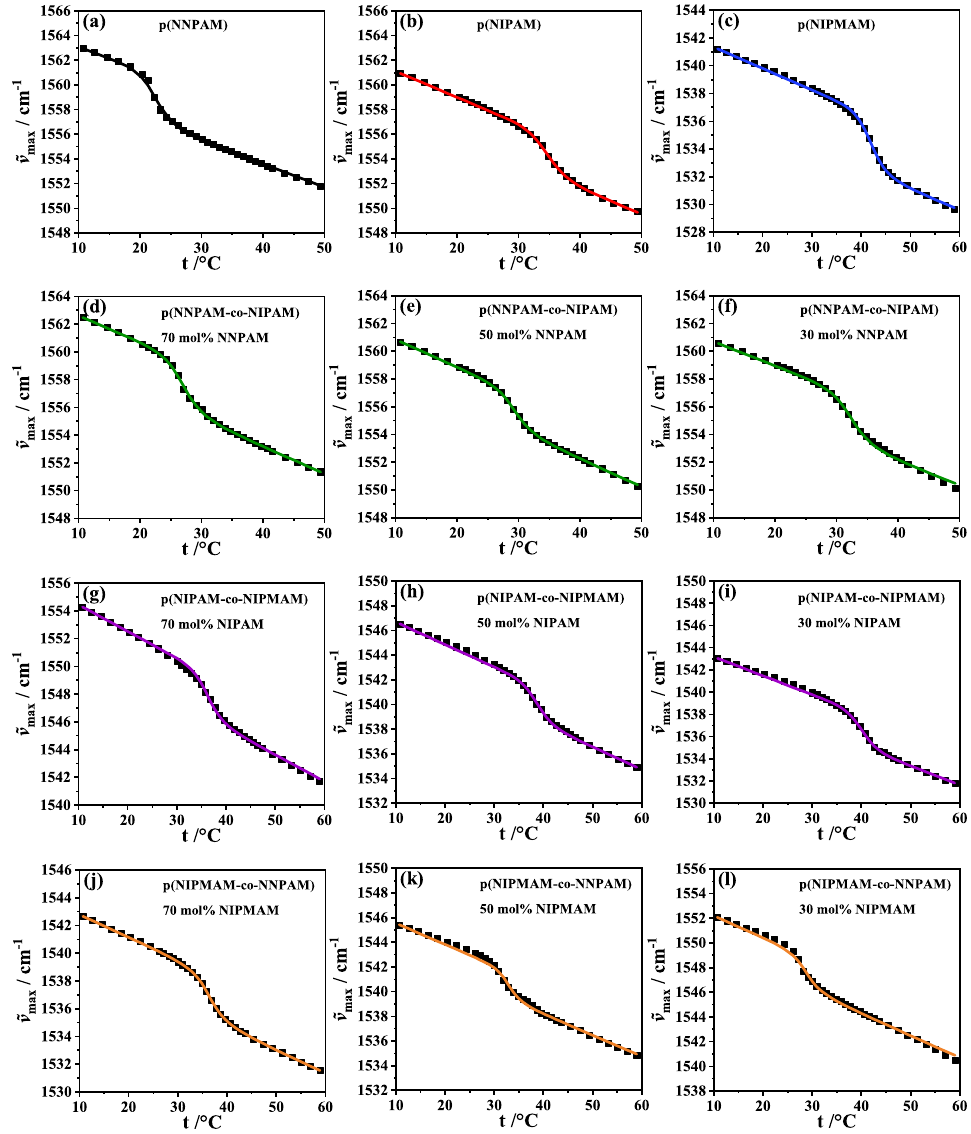
Figure 6. Maximum of the δ (N–H)-bending vibration band ˜ ν max vs. temperature t of homopolymer systems poly(NNPAM) ( a ), poly(NIPAM) ( b ) and poly(NIPMAM) ( c ) and of copolymer systems poly(NNPAM-co-NIPAM) ( d – f ), poly(NIPAM-co-NIPMAM) ( g – i ) and poly(NIPMAM-co-NNPAM) ( j – l ) at different comonomer contents (30 mol%, 50 mol% and 70 mol%). Squares are experimental data, solid lines represent the fitting curves. ˜ ν max of the homopolymer and copolymer systems are fitted using the Hill-like Equation (14). A nearly perfect fit to the experimental data was achieved for all microgel